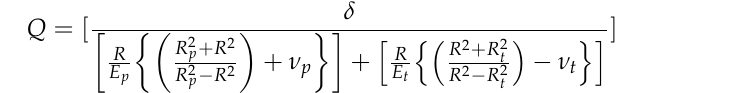
Figure 8. ( a ) Front section view of the raised feature showing the interface pressure due to shrinkage